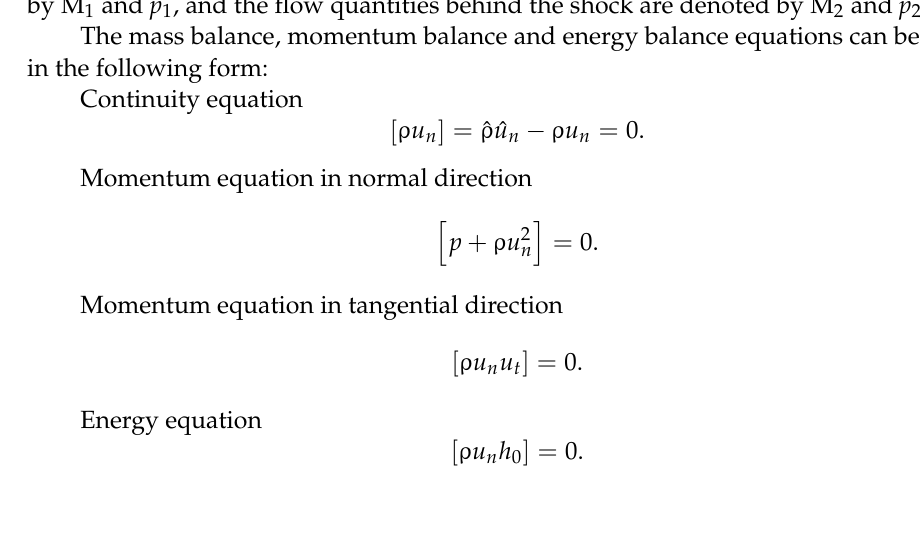
→ → σ σ 5 . 1 or   or σ . 1 5